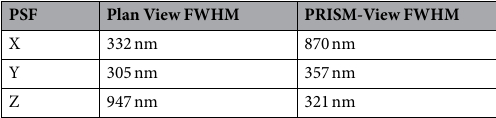
Table 1. Point Spread Function for Vertical Light